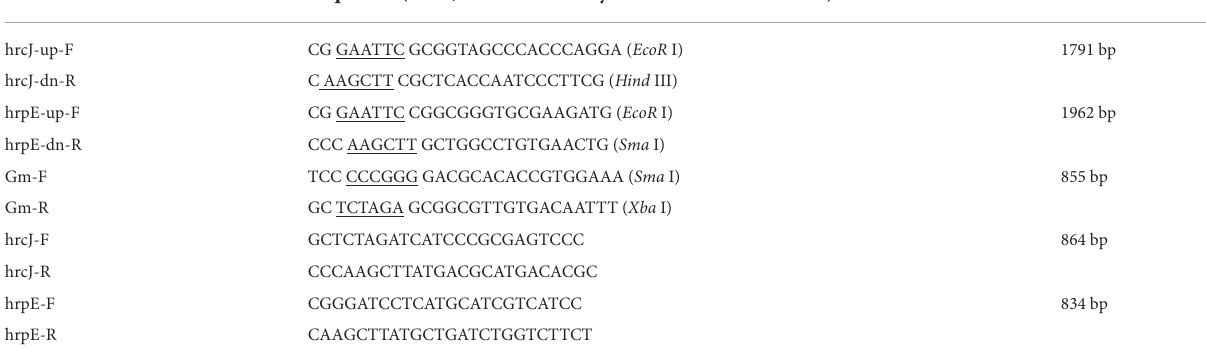
TABLE 2 PCR primers used in this